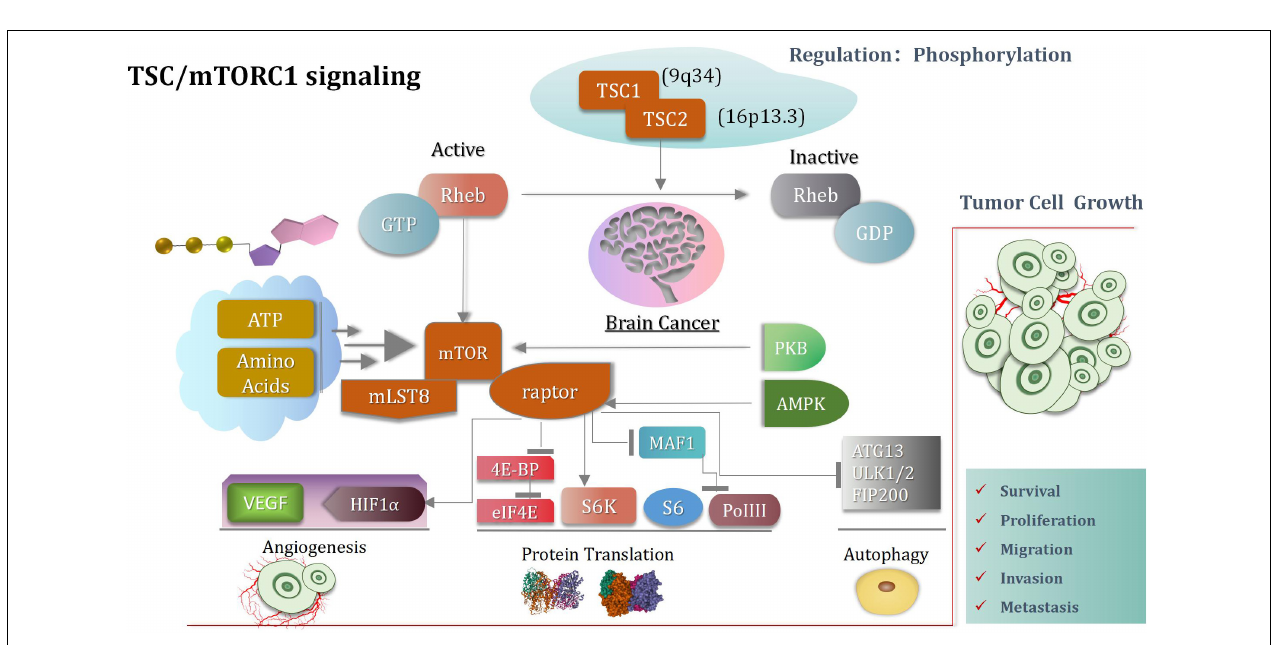
FIGURE 2 | The mechanism of PI3K/AKT/mTOR signaling pathway in glioma.